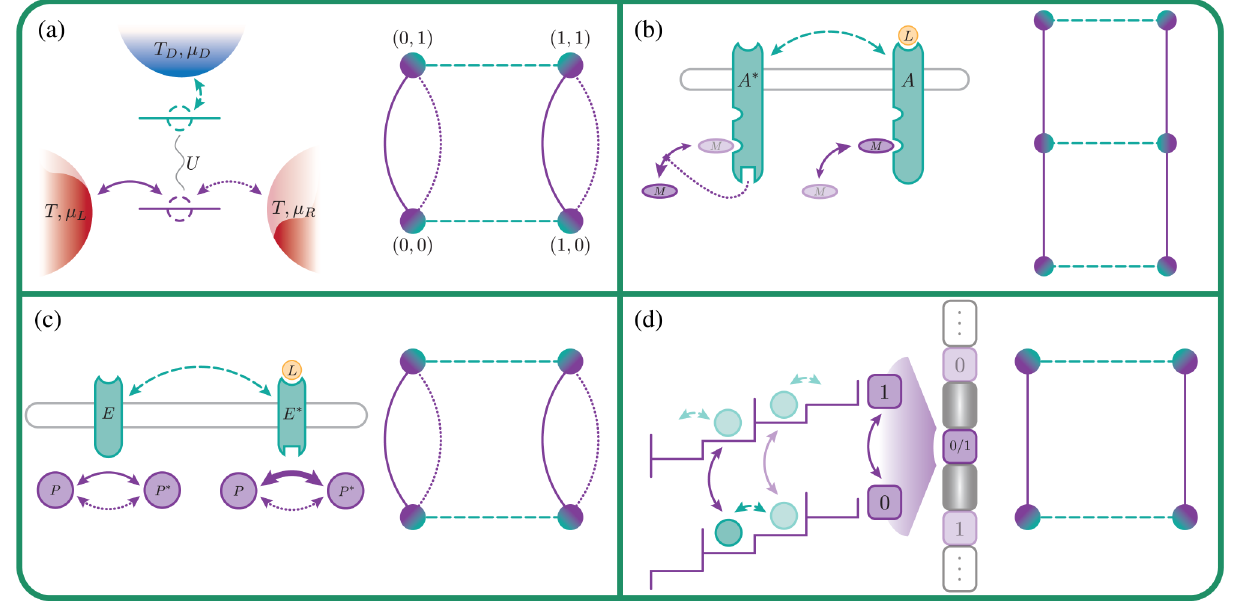
FIG. 2. Bipartite examples: (a) Quantum-dot Maxwell demon: A single-level quantum dot (purple) exchanges electrons with two particle reservoirs (or leads), left and right, at temperature T with chemical potentials μ L and μ R , causing jumps between empty 0 and filled 1 states. An upper “ demon ” dot (teal), connected to a particle reservoir at temperature T D and chemical potential μ D , is capacitively coupled to the lower dot with interaction energy U (wavy gray line). The demon dot operates as a measurement and feedback device that can drive a particle current from right to left against a chemical potential difference Δ μ ¼ μ L − μ R > 0 [37]. (b) Biological sensory adaptation: A transmembrane enzyme fluctuates between an active configuration A (cid:2) and inactive configuration A due to the binding of a extracellular ligand L (yellow dot). In the active state A (cid:2) , the enzyme, through a sequence of reactions (dotted purple curve), speeds up the removal of bound methyl groups M (purple ovals). This feedback loop shifts the enzyme ’ s stability, so as to maintain it in the same adapted distribution no matter the ligand concentration [62]. (c) Biologically inspired model of sensing: A transmembrane receptor enzyme E (teal) is activated by the binding of an extracellular ligand L (yellow dot). The activated enzyme E (cid:2) speeds up one of two nonequilibrium reactions that promote a protein P (purple dots) to its active configuration P (cid:2) . In this way, the concentration of L is recorded in the concentration of P (cid:2) [39,40]. (d) Model information engine: A Brownian particle (teal) diffuses in a tilted energy landscape. One by one, a sequence of two-level bits (purple) with states 0 and 1 are coupled to the particle. Measurement and feedback are performed through a nonautonomous process that simultaneously flips the bits while switching the energy landscape. By biasing uphill potential flips with a nonequilibrium force (not shown), the particle can be driven preferentially uphill in order to extract work. The graph depicts the interaction of the particle with one bit and is periodic in the particle ’ s position